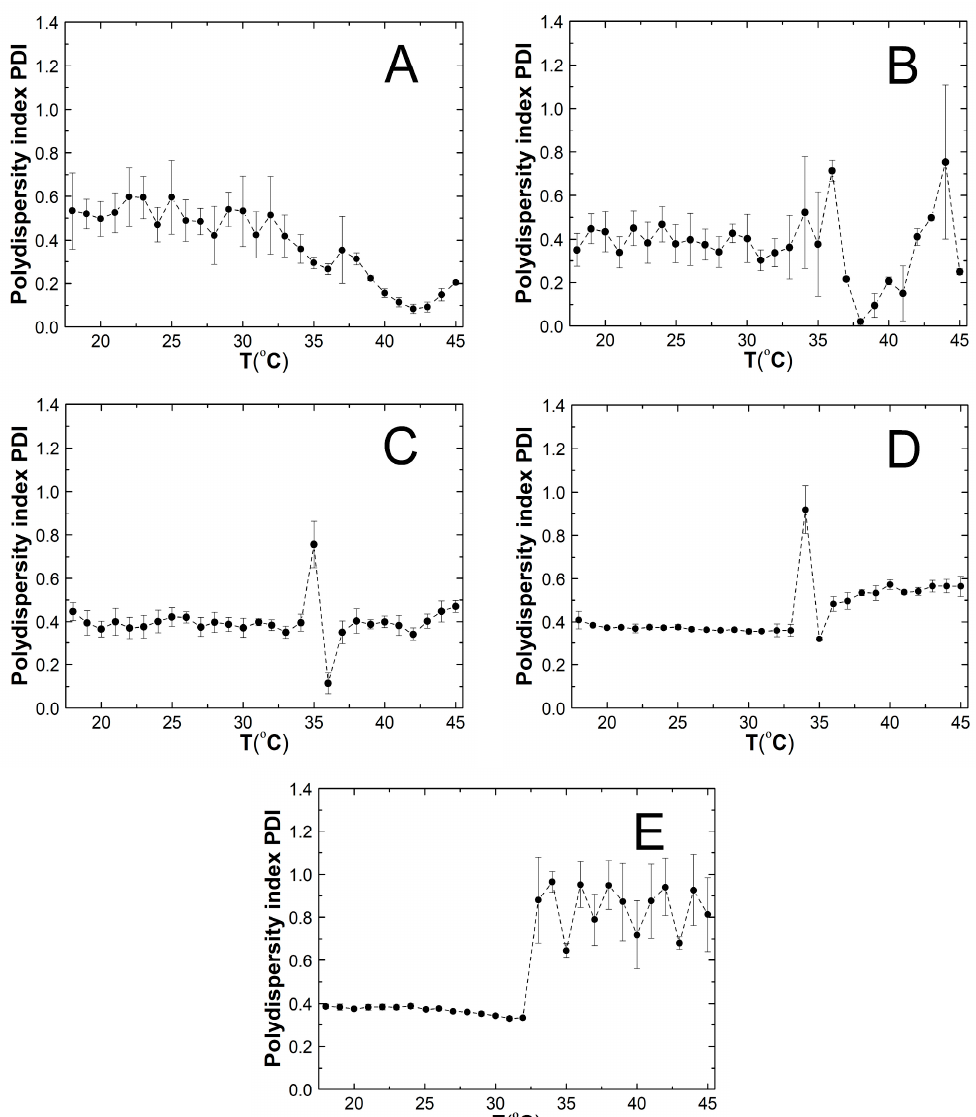
Figure 8. The effect of the temperature on the polydispersity index (PDI) of the prepared nanoparticles P1 ( A ), P2 ( B ), P3 ( C ), P4 ( D ), and P5 ( E ) obtained from dynamic light scattering (DLS)